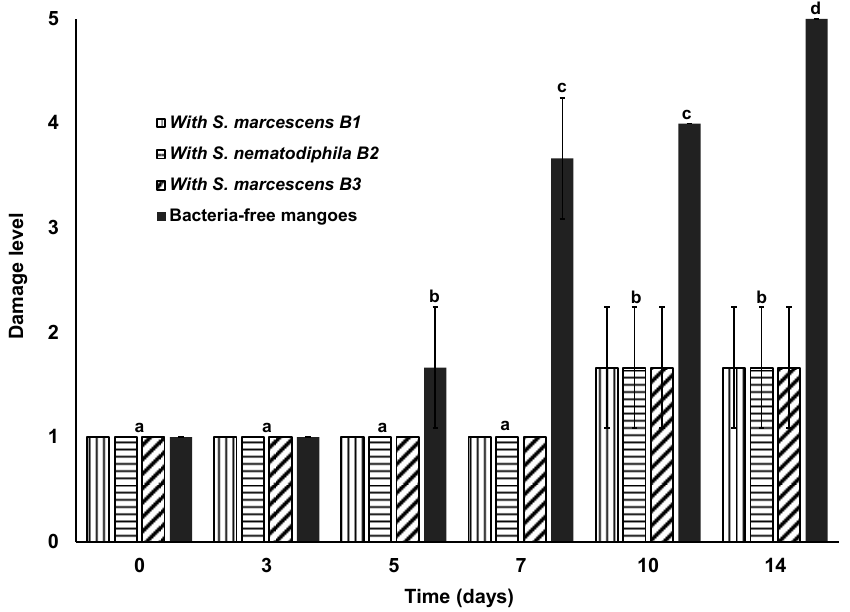
Figure 4. Mangoes with undamaged surfaces inoculated with C. siamense and treated with strains of Serratia . The damage level means, 1: between 0 to 1% of damage; 2: between 1 to 5% of damage; 3: between 6 to 9% of damage; 4: between 10 to 49% of damage and 5: between 50 to 100% of damage. Different letters in the columns on the different days of treatment mean a statistically significant difference ( p < 0.05).